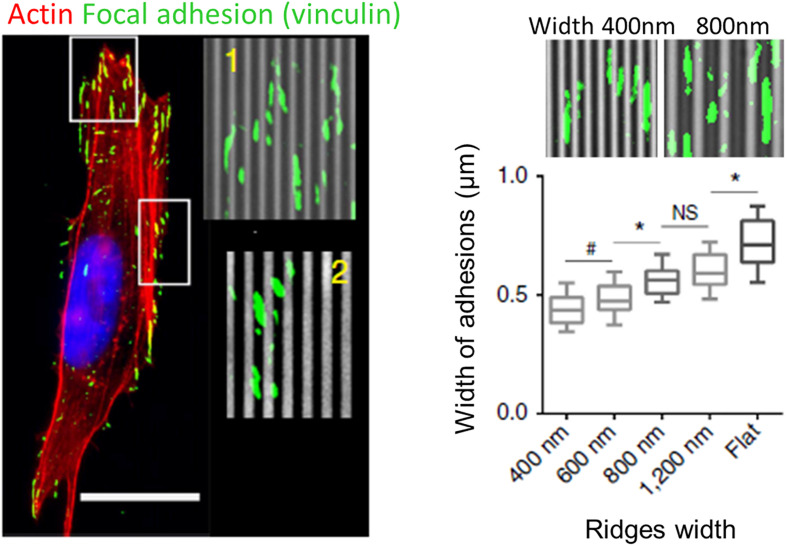
Role of focal adhesions (FA) in topography sensing. Left: cancer cell aligned on a nanogrooved substrate stained for actin (red), vinculin (green), and nucleus (blue). Insets shows aligned FA (1) or non-aligned FA complexes (2). Scale 20 μm. Right: Relationship between ridges width and FA width. From Ray et al. (2017). Symbols correspond to the p-values of the statistical tests performed: #P < 0.05, *P < 0.001, NS = no significance (ANOVA).